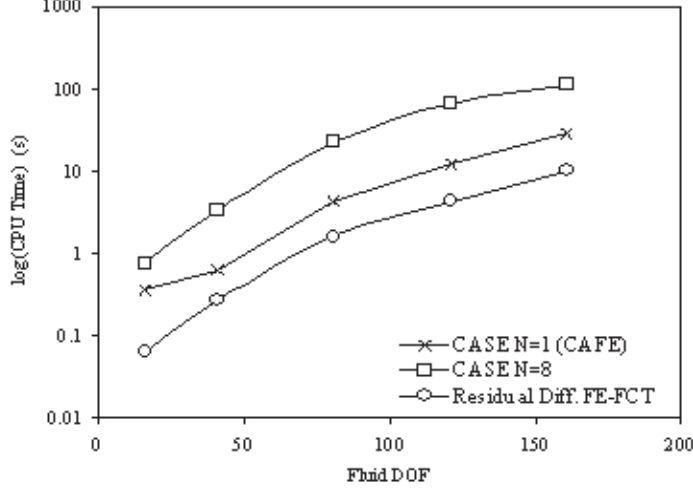
Fig. 19. Comparison of the CPU time required to solve the mass-spring oscillator problem for a given number of DOF for the CAFE ( β = 0.50), CASE ( β = 0.50), and FE-FCT ( η D = 0.125, η A = 0.09)